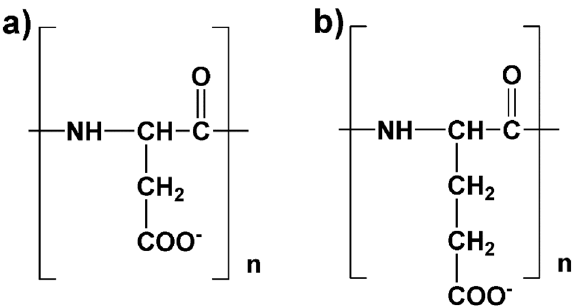
Figure 1. The chemical structures of ( a ) poly-( α - L aspartic acid) (PASA) and (b ) poly-( α - L glutamic acid) (PGA) molecules. The degree of polymerization (n) in the simulations was 32.